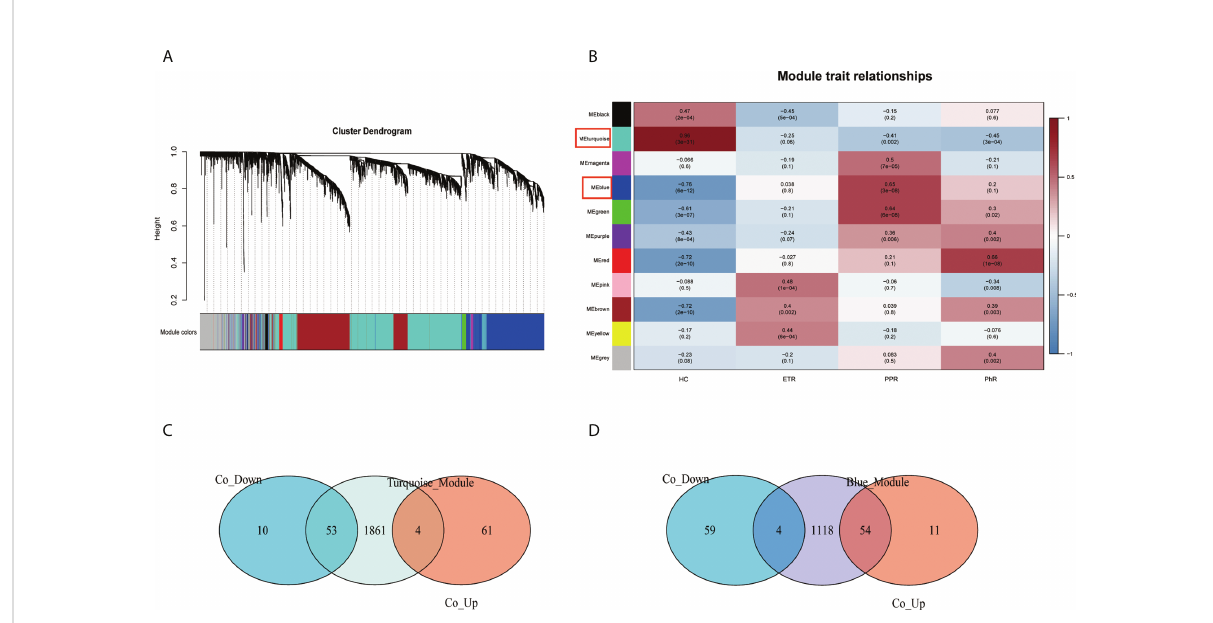
FIGURE 4 Construction of the weighted gene co-expression network analysis model for the GSE65914 dataset: (A) network heat map of all genes, (B) relationship between modules and trait, (C) Venn diagram of the turquoise module and the overlapping DEGs, and (D) Venn diagram of the blue module and the overlapping DEGs. DEGs, differentially expressed